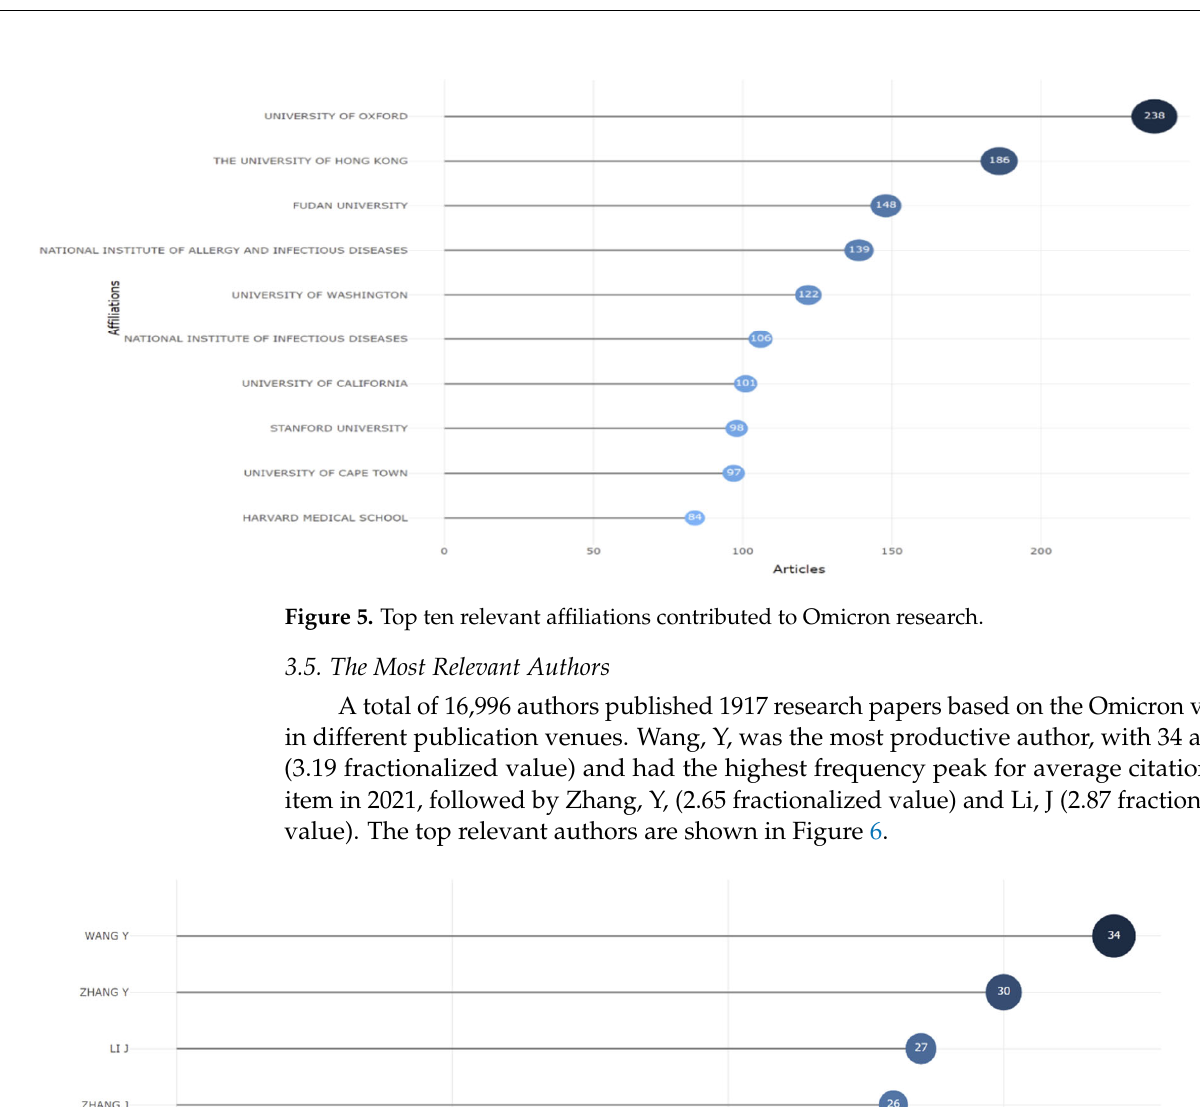
Figure 4. Top ten highly cited journals based on Omicron variant research.